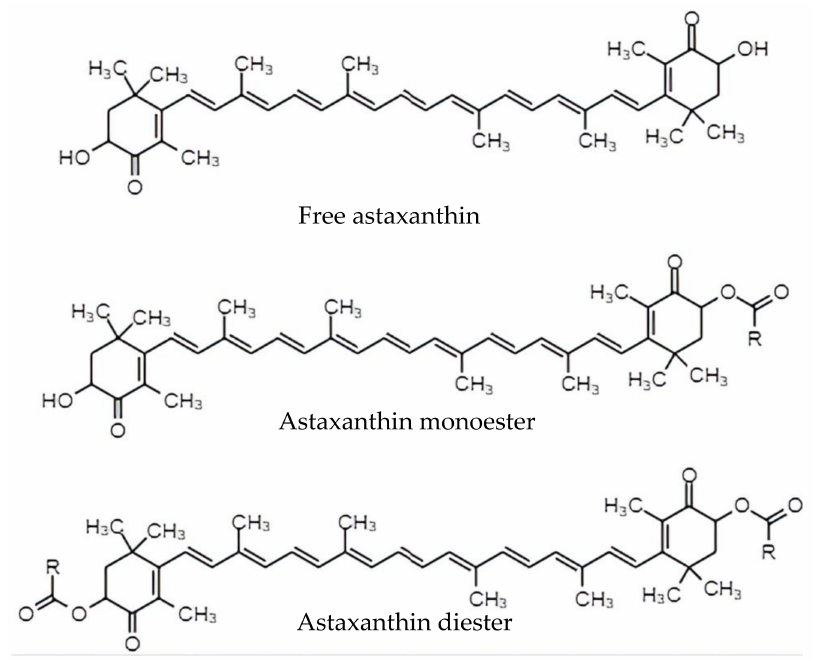
Figure 1. Free form, monoester and diester molecular structure of